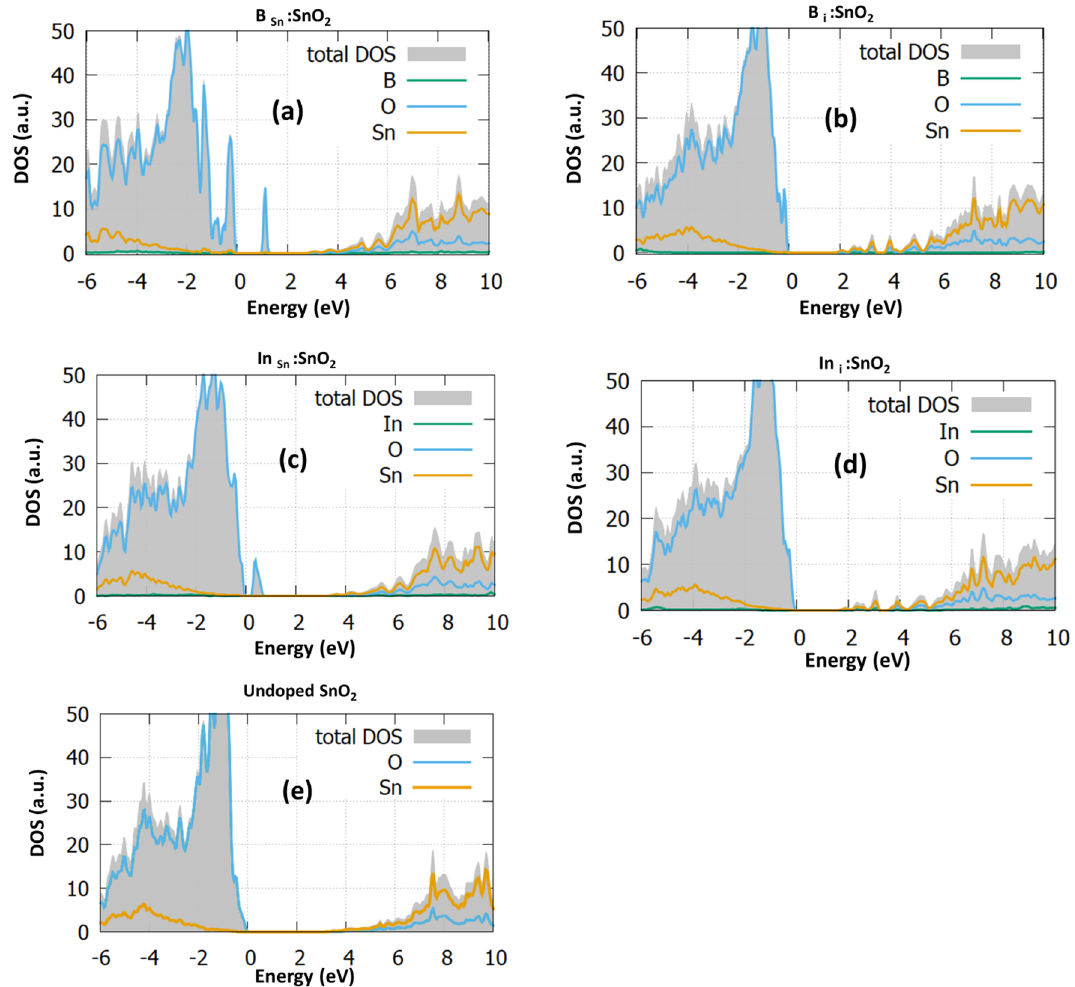
Figure 2. The total density of states (DOS) and the projected density of states (PDOS) of ( a ) B Sn :SnO 2 , ( b ) B i :SnO 2 , ( c ) In Sn :SnO 2 , ( d ) In i :SnO 2 and ( e ) undoped SnO 2